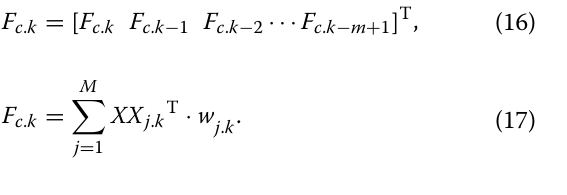
where X j . k is the N × 1 dimensional vector corresponding to the j th state variable of the reference signal, and w j . k is the N × 1 dimensional tap-weight vector at time k ; XX j . k T is the m × N matrix of the reference signal correspond- ing to the current and past j th state variable at time k ; c is the n × m finite pulse filter corresponding to the trans- fer function of control channel; µ is the step factor; f j . k is the signal filtered by the finite pulse filter c for the ref- erence signal corresponding to the j th state variable; L is target-weight matrix; N , M , m and n indicate the order of the x -LMS filter, the number of state parameters and the order of the finite pulse filter corresponding to the con- trol channel respectively. For the iterative Eqs. (14b) and (14c) of the tap-weight vector in the x -LMS algorithm with state feedback, tak- ing system state parameter X j . k as reference signal, the control signal F c . k can be expressed